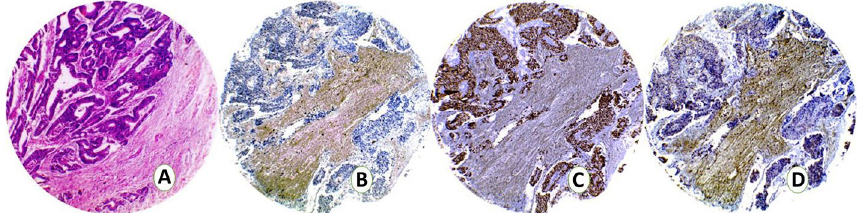
Fig. 4 TMA sections from a UC case assigned as luminal subtype showing. A : H&E B :CK5/6 negative. C : GATA3 nuclear positivity. D : P53 negative